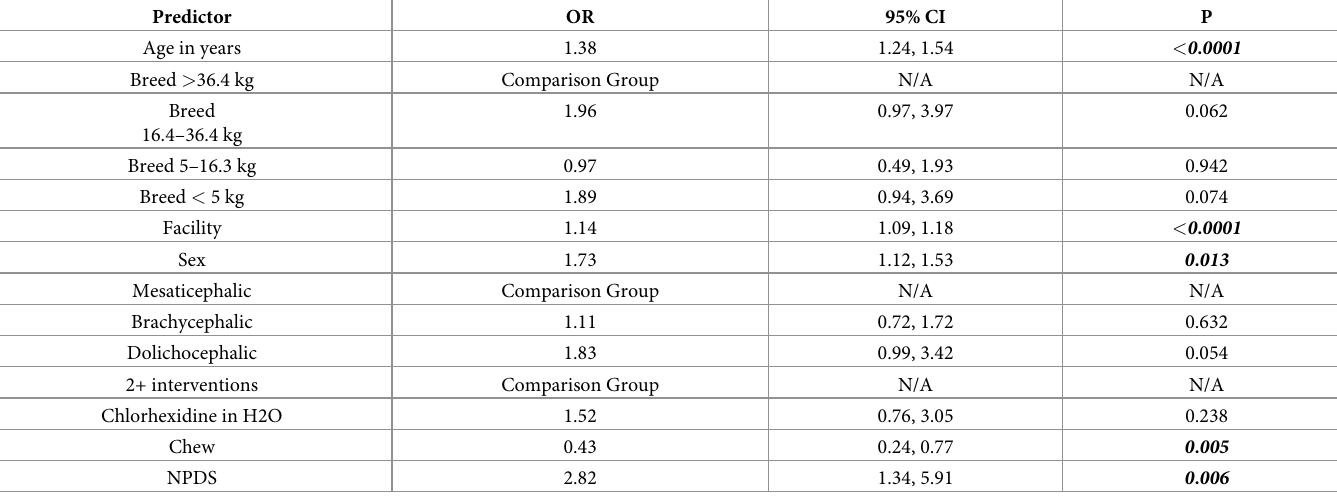
Table 2. Results of ordered logistic regression (OLR) NPDS Non-professional dental scaling.